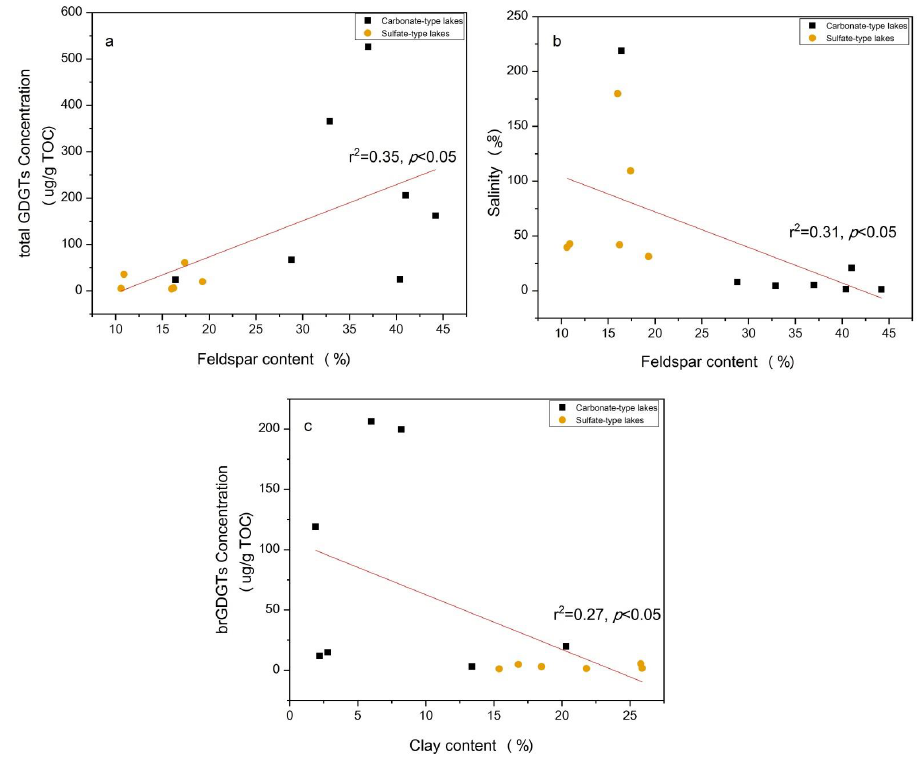
Figure 7. Comparison of ( a ) feldspar content and concentration of total GDGTs; ( b ) feldspar content and salinity; ( c ) clay content and concentration of brGDGTs in 13 surface sediments (feldspar content = Kfs +